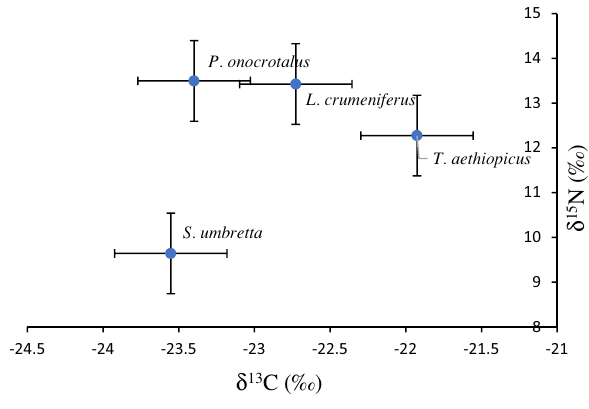
Fig. 4 Trophic position of bird species sampled from Lake